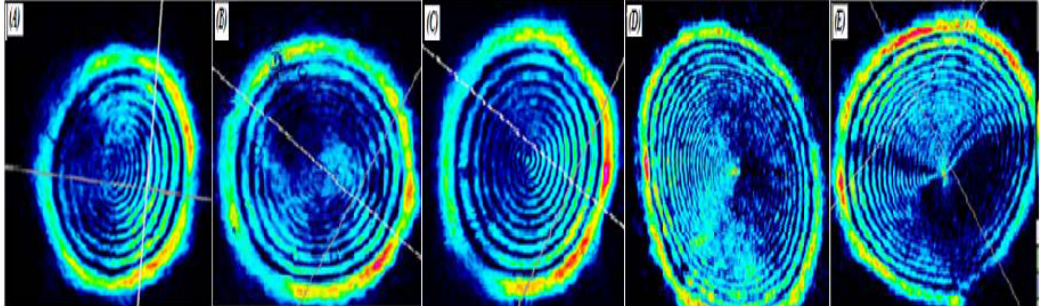
Fig.15: Non-linear diffraction produced by MWCNTs at volume fraction 13x10 -5 at laser intensity: (A)130.41, (B) 169.81, (C) 238.31, (D) 285.69, and (E) 353.38 W / cm 2 .